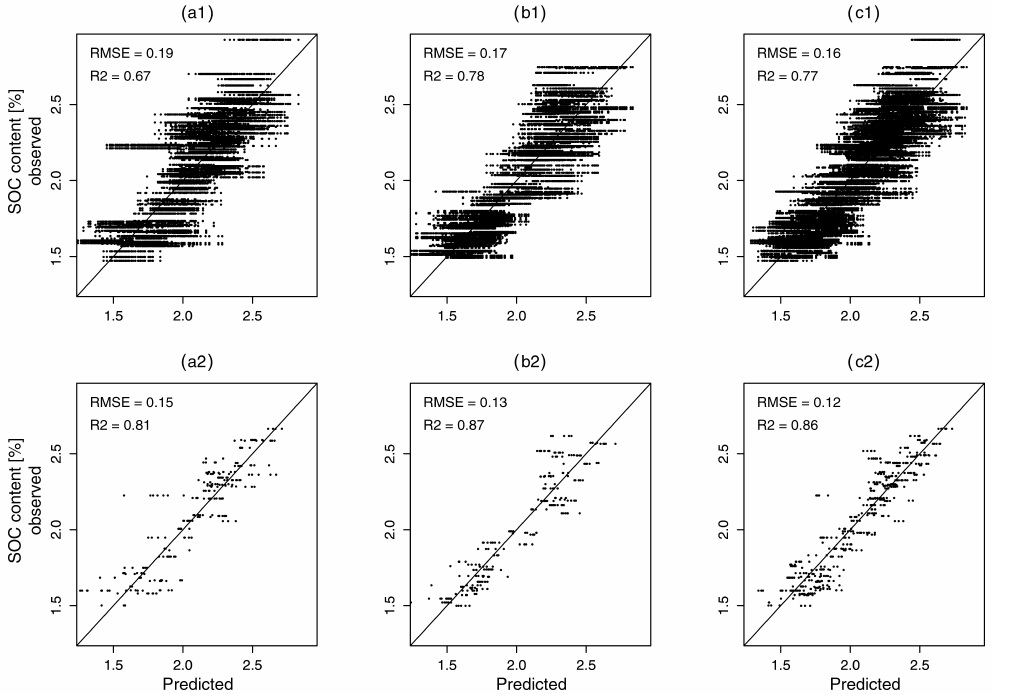
Figure 9. Comparison of predicted and observed soil organic carbon (SOC) values for Dataset 111 ( a1 to c1 ) and Dataset 000 ( a2 to c2 ) for five repetitions with the corresponding best pre-processing (SGCR for data A and all data, SG for data B); (a) shows results for A samples, (b) for B samples, and (c) for all samples. The depicted RMSE and R 2 values refer to the mean of five